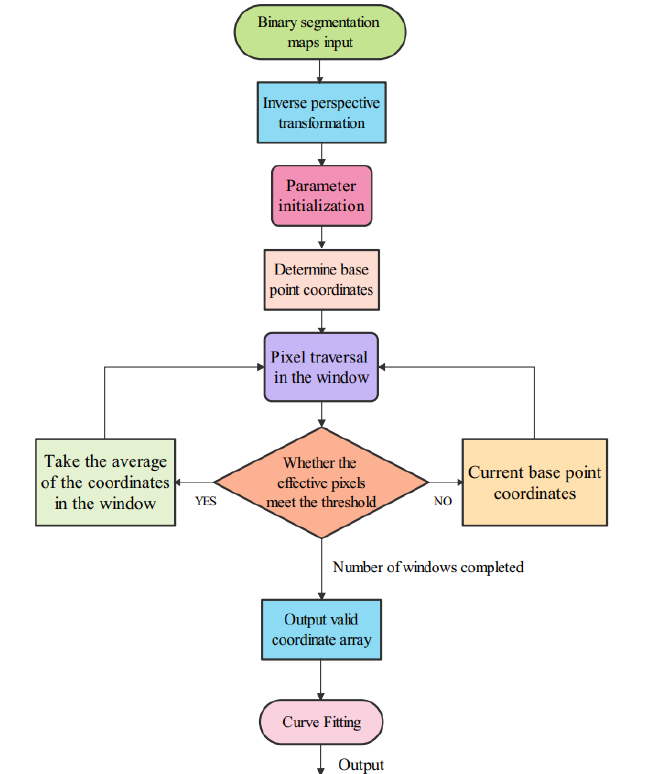
Figure 5. Flow diagram of the rail lines fitting algorithm based on sliding window